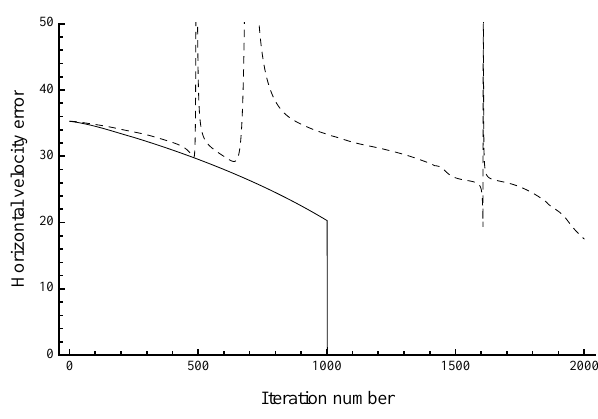
Fig. 7. Conjugate gradient convergence history for the reformulated Stokes system (solid line) and the standard Stokes system (dashed line) for a relatively large problem ( N = 1000, h = 0 .